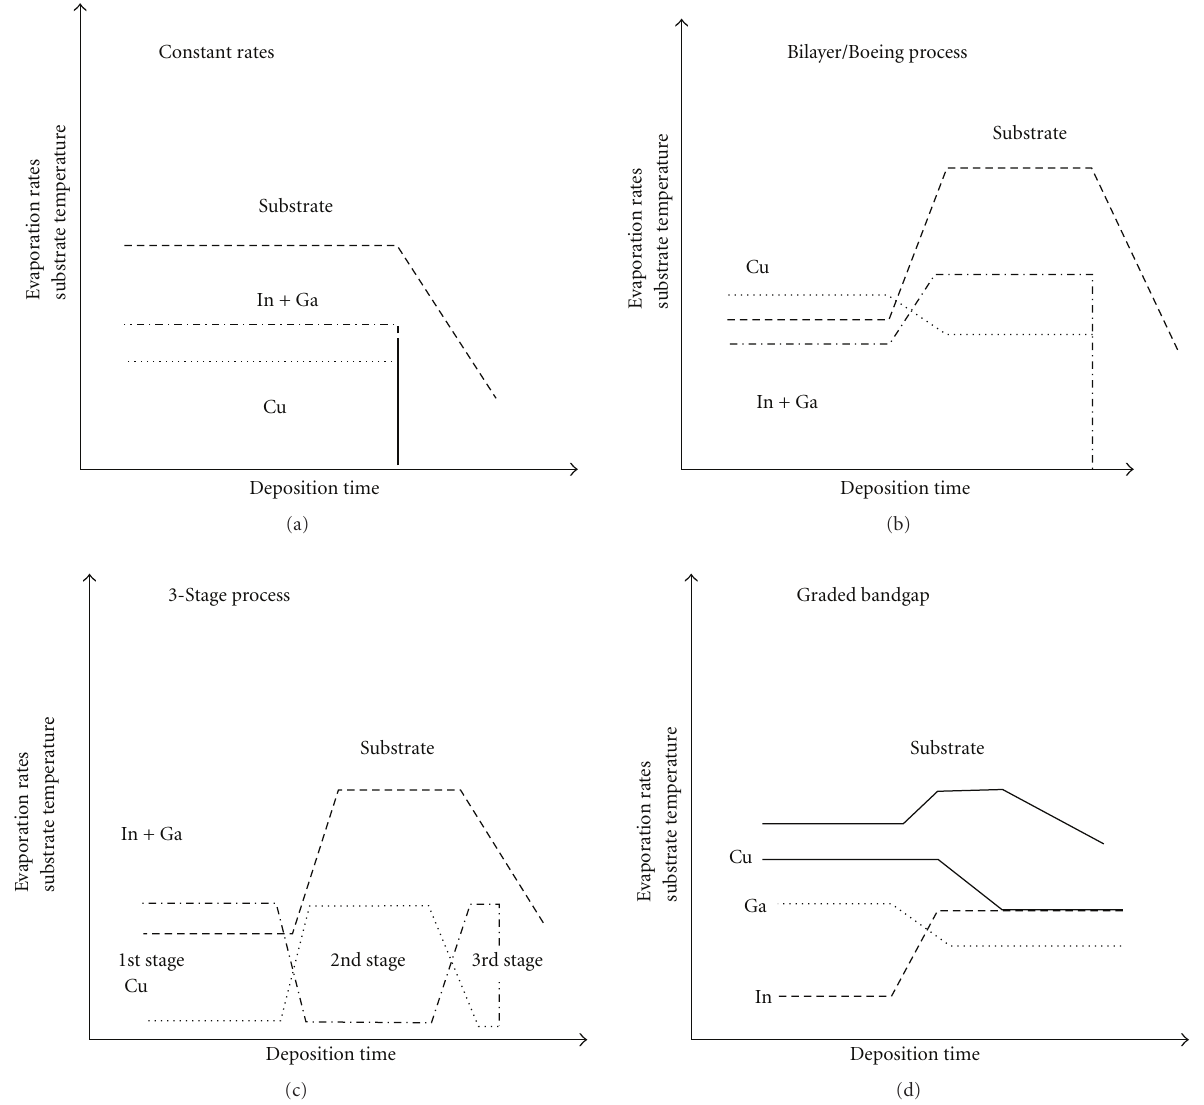
Figure 4: Schematic illustration of di ff erent coevaporation process. In all cases, a constant Se flux is also supplied.